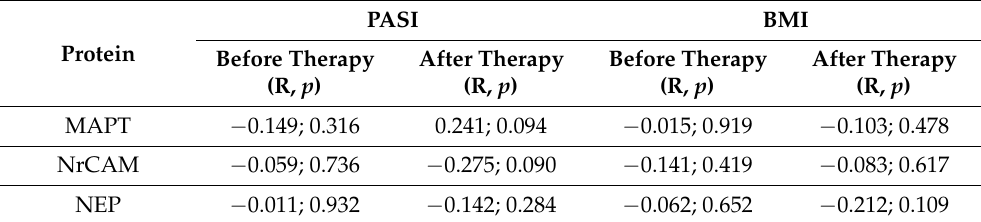
Table 2. Correlations of the proteins with PASI and BMI before and after total therapy.